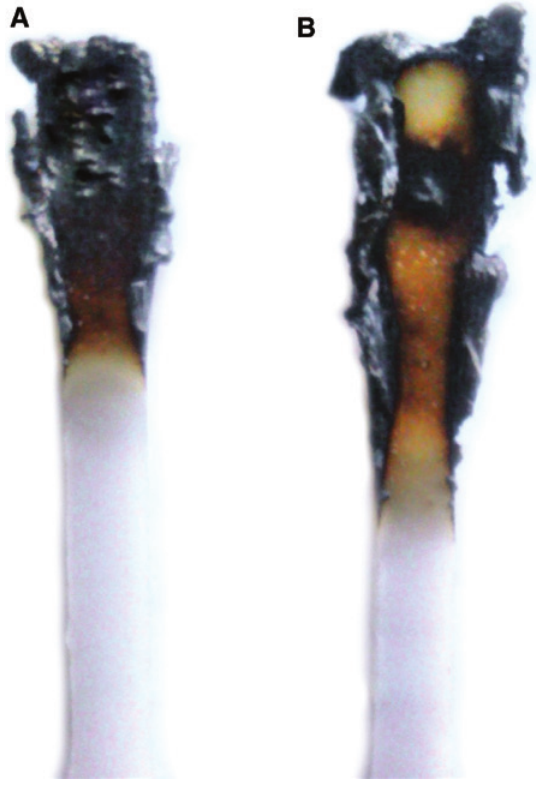
Figure 2: The char residue in: (A) 20APP and (B) 15APP5AG.